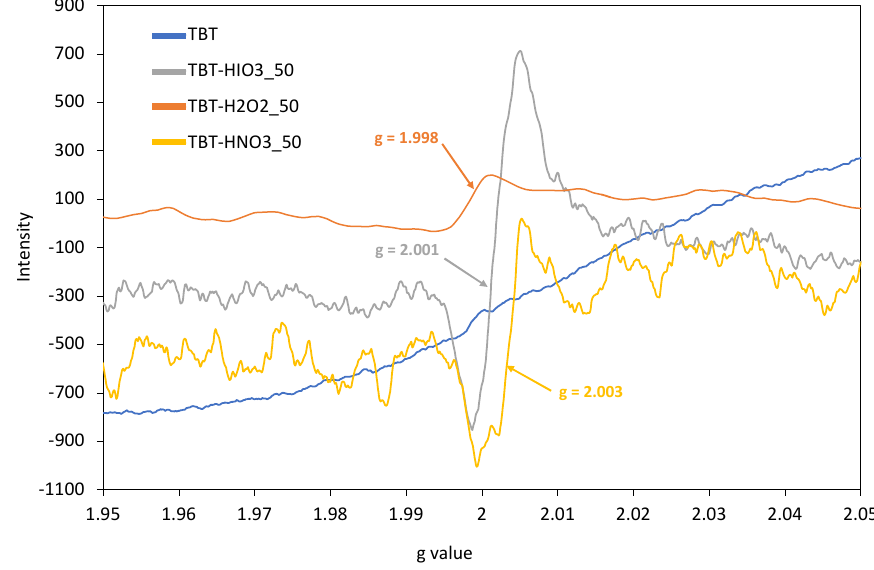
Figure 3. The EPR spectra recorded in the room temperature for defective TiO 2 photocatalysts obtained in different oxidative environments, compared with pure TBT-TiO 2 sample (blue line). For defective TiO 2 samples, an intense signal was noticed in the range of g from 1.998 to 2.003 for TBT-H 2 O 2 _50 and TBT-HIO 3 _50 samples, respectively. According to the literature, it could